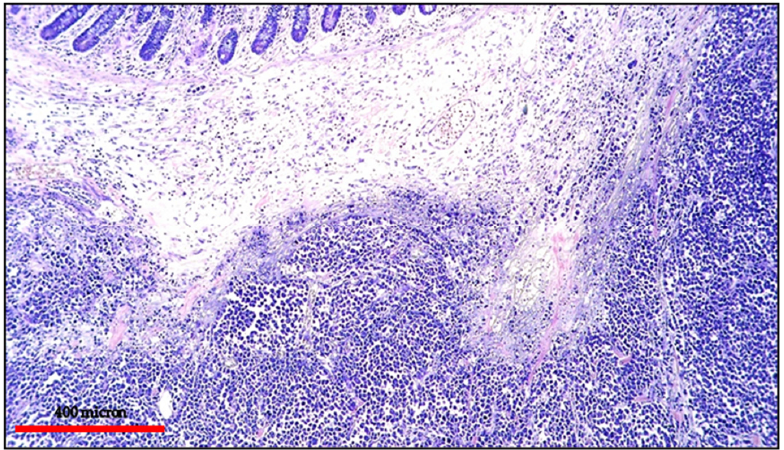
Figure 4. EC-PEL of the ileum: low power view of the neoplastic proliferation involving the bowel wall (Giemsa staining, magnification 100×; original image from Prof Ascani).